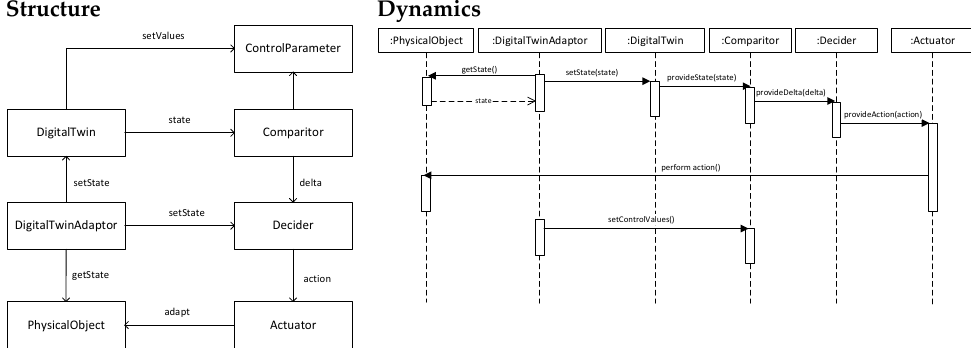
Figure 15. Digital Autonomy pattern.